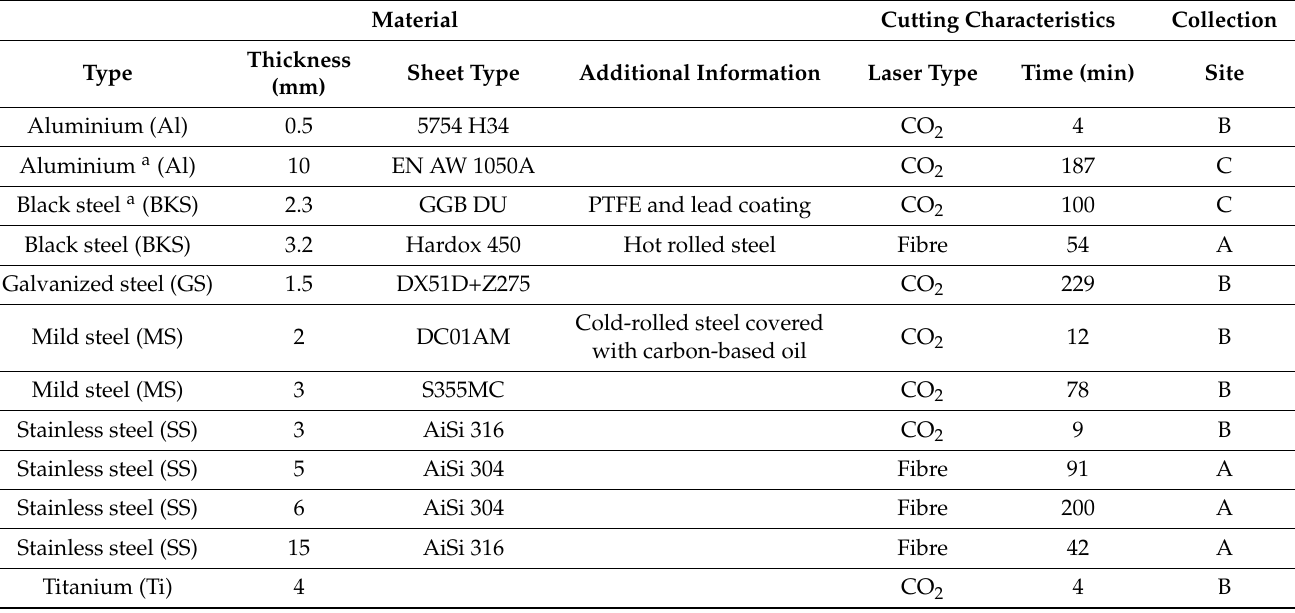
Table 1. Metal sheet information and laser cutting